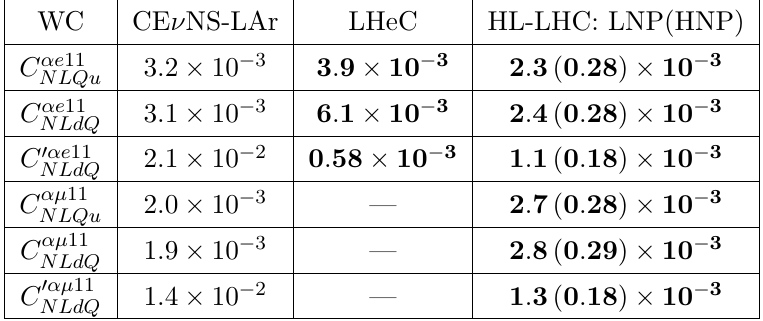
Table 4. Projected 90% C.L. bounds on the three SMNEFT WCs C NLQu , C NLdQ , and C 0 with electron and muon (cid:13)avor, at 1 TeV energy scale. The constraints obtained by allowing all WCs to simultaneously vary are in boldface.